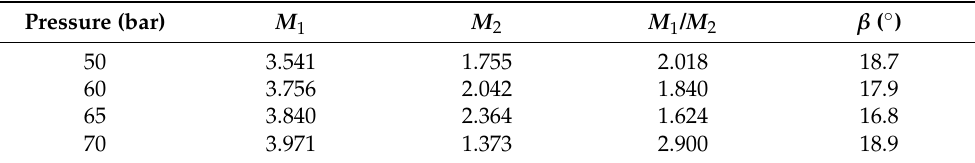
Figure 17. Heat flux characteristics of the baseline diffuser after separation. Table 4. Numerical Mach number and theoretical shock